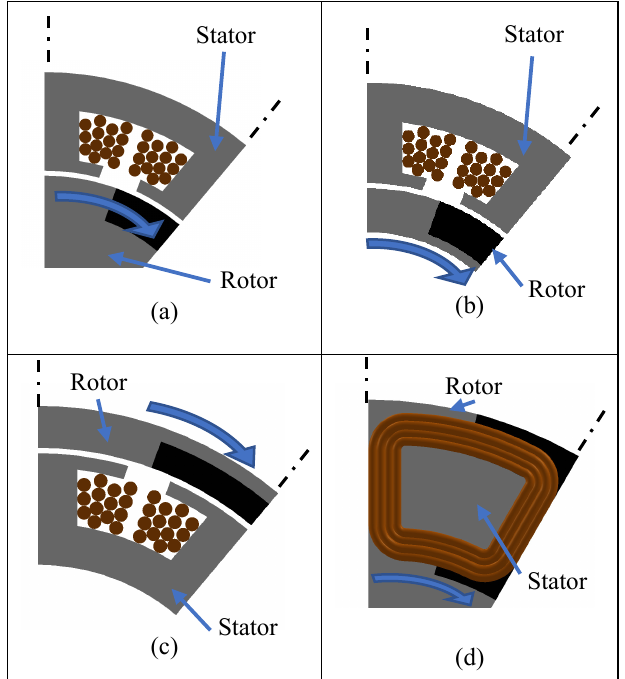
Figure 4. Electric propulsion motor architectures: ( a ) Radial flux shaft drive; ( b ) radial flux inrunner rim drive; ( c ) radial flux outrunner drive; ( d ) axial flux shaft